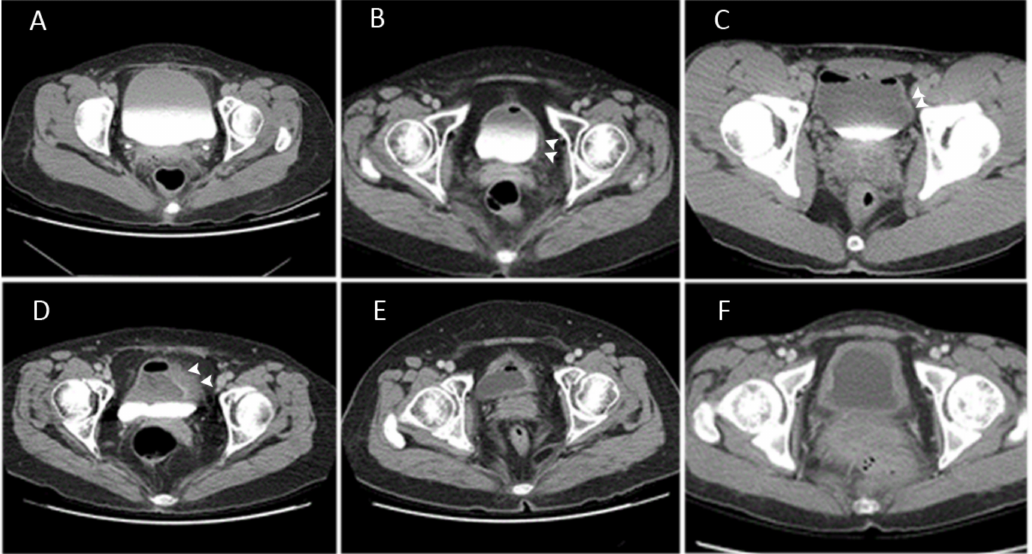
Figure 1. Representative computed tomography (CT) scan bladder images in patients with interstitial cystitis/bladder pain syndrome: ( A ) smooth bladder wall; ( B – D ) focal bladder wall thickening (white arrow head); ( E , F ) diffuse bladder wall